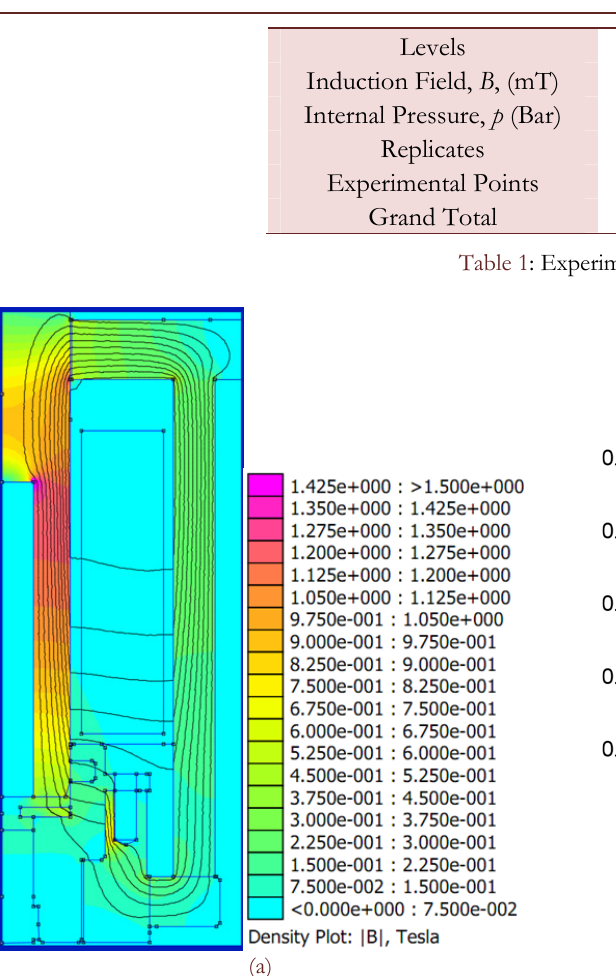
Figure 4: Flux density inside the hydro-magnetic system for a current of 2.31 Amp (a), scale 0-1.5T, and flux distribution along the radius of the MR fluid chamber (b).